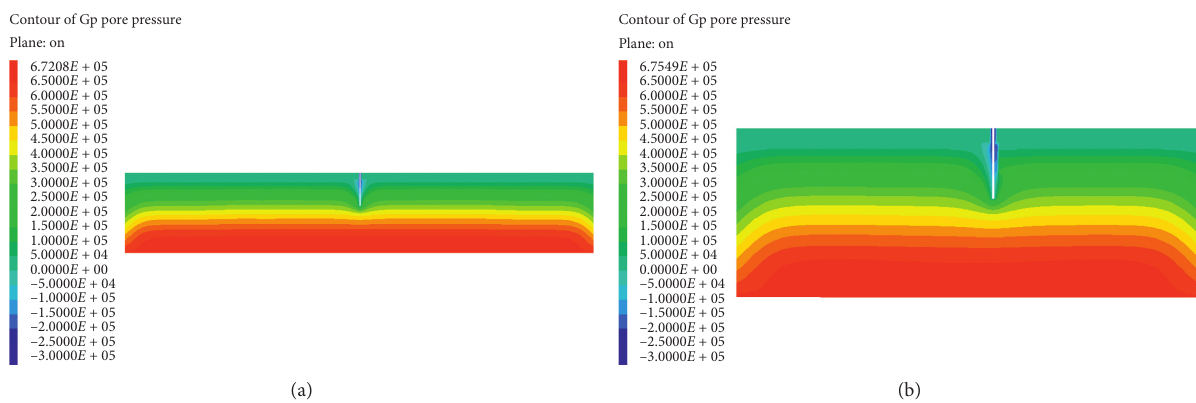
Figure 23: Single well pore water pressure nephogram when the drawdown is stable (unit: Pa). (a) Cross section of the well midpoint. (b) Longitudinal section of the well